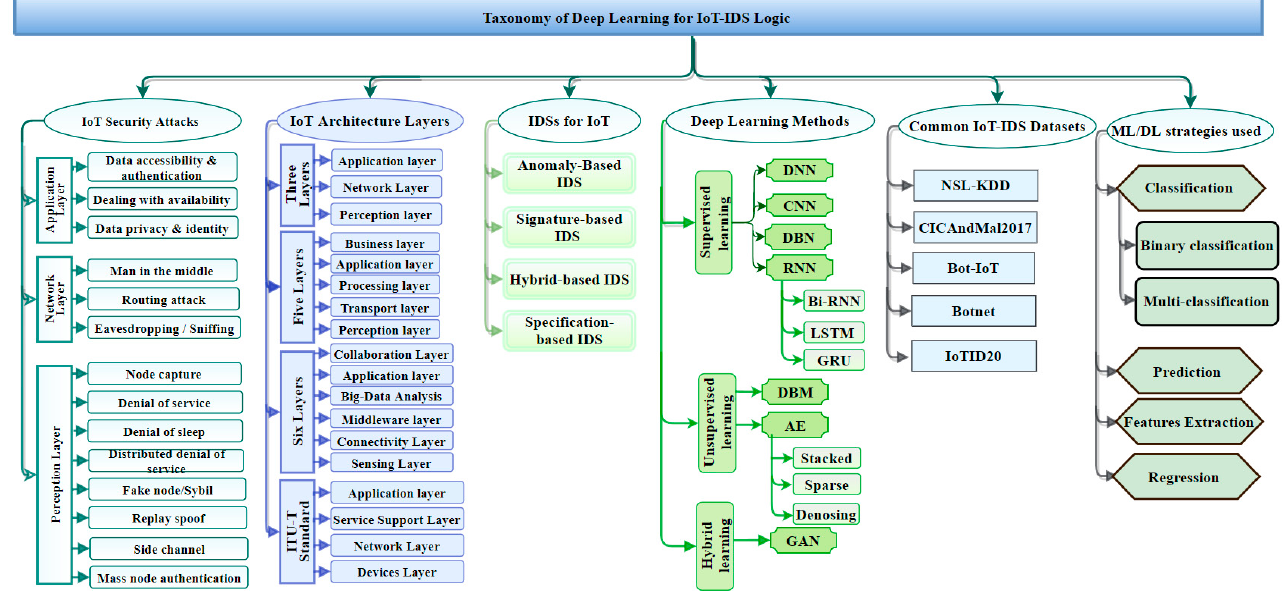
Figure 1. Taxonomy of Deep Learning for IoT-IDS Logic.